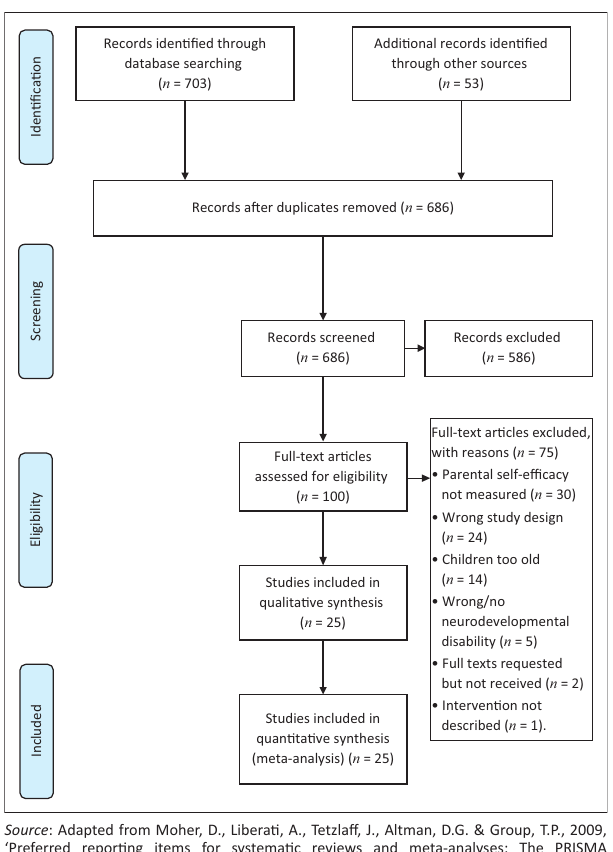
FIGURE 2: Preferred Reporting Items for Systematic Review and Meta-Analyses (PRISMA) flow chart presenting the documentation and selection of included studies in the systematic